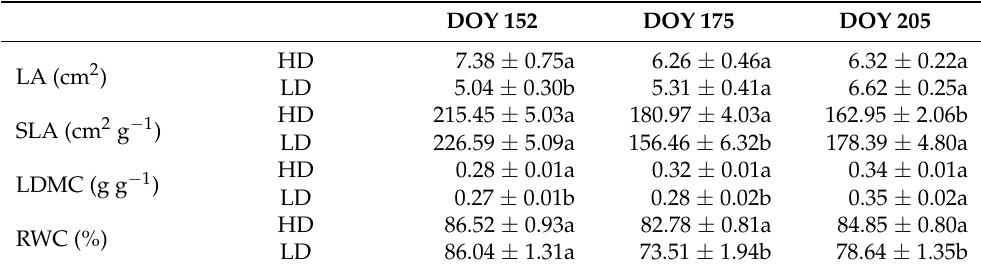
Table 1. Leaf area (LA), specific leaf area (SLA), leaf dry matter content (LDMC), and relative water content (RWC) of R. pseudoacacia HD and LD plants at DOY 152, 175, and 205. Mean values and standard errors are shown. Different letters correspond to statistically significant differences ( p < 0.05) within each date of sampling.